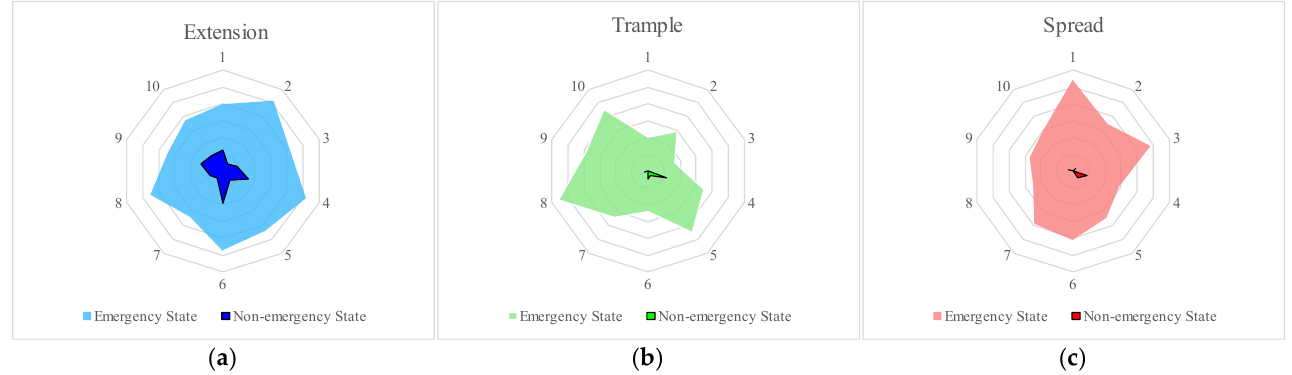
Figure 16. Radar charts of different behavior categories. ( a ) time of extension, ( b ) time of trample, ( c ) time of spread.